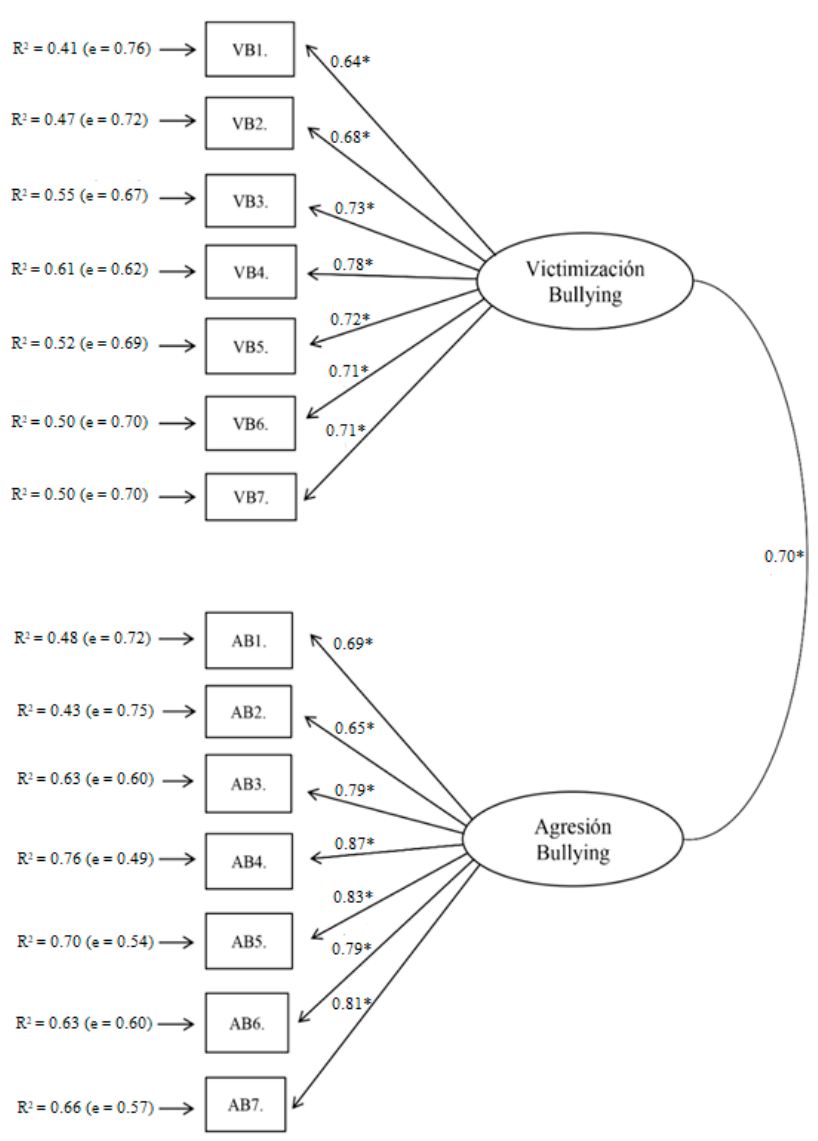
Figure 2. CFA of the adapted EBIPQ to report discrimination around special educational needs (SEN) (* p < 0.05).